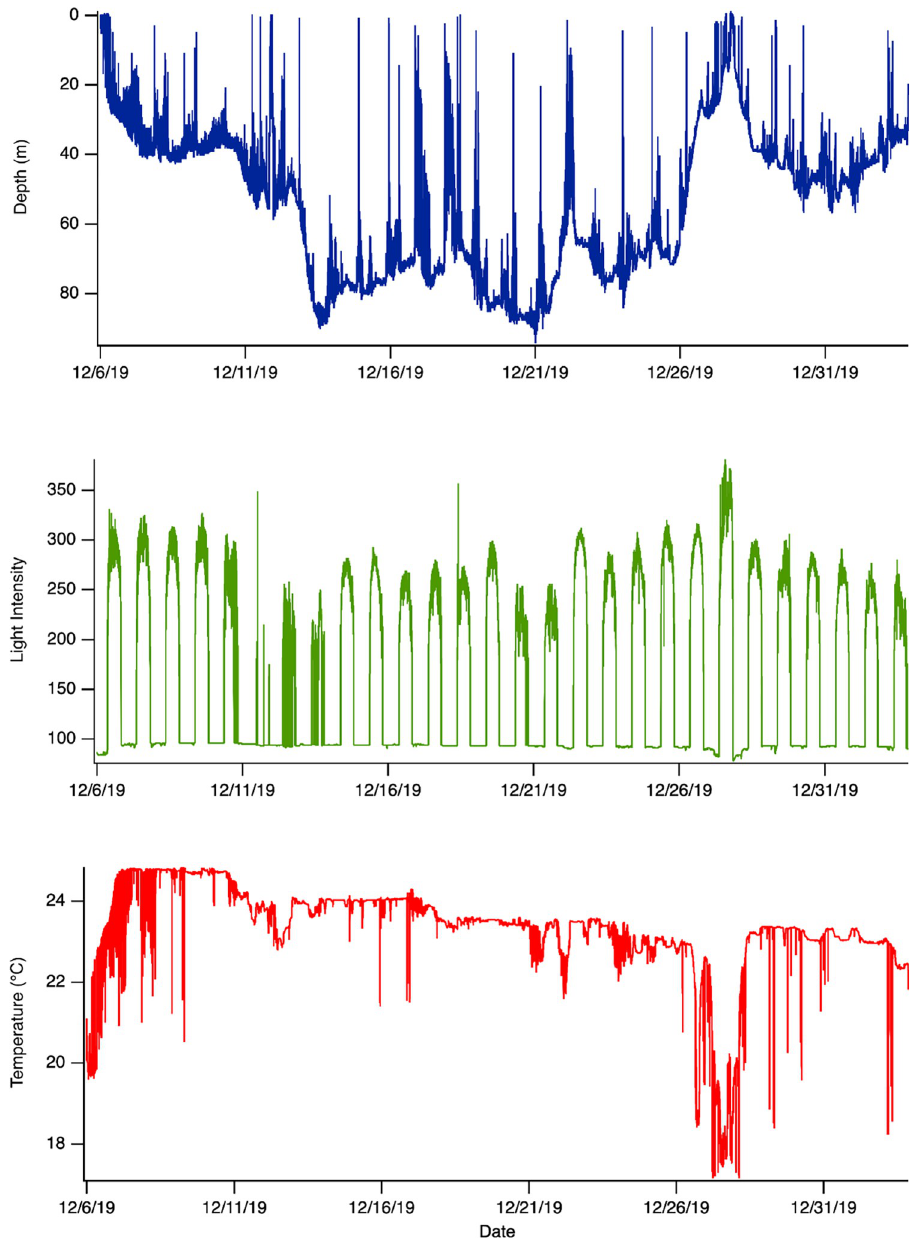
Fig 2. Example of recovered PSAT data from a blacktip shark (C_lim03). Consistent changes in depth, temperature, and light level with ambient ocean conditions indicate survival. changes in swimming metrics over the hours post release. Blacktip sharks displayed increasing TBP which appeared to stabilize approximately 36 hours after release and a decrease in ODBA over the initial 20 hours post release before stabilizing. Trends in bull shark behavior post release were more variable without clear patterns of a recovery period; TBP increased while ODBA decreased over the initial 12–16 hour period after release. After this period, there was a decrease in the number of available datasets and an increase in the displayed variability in